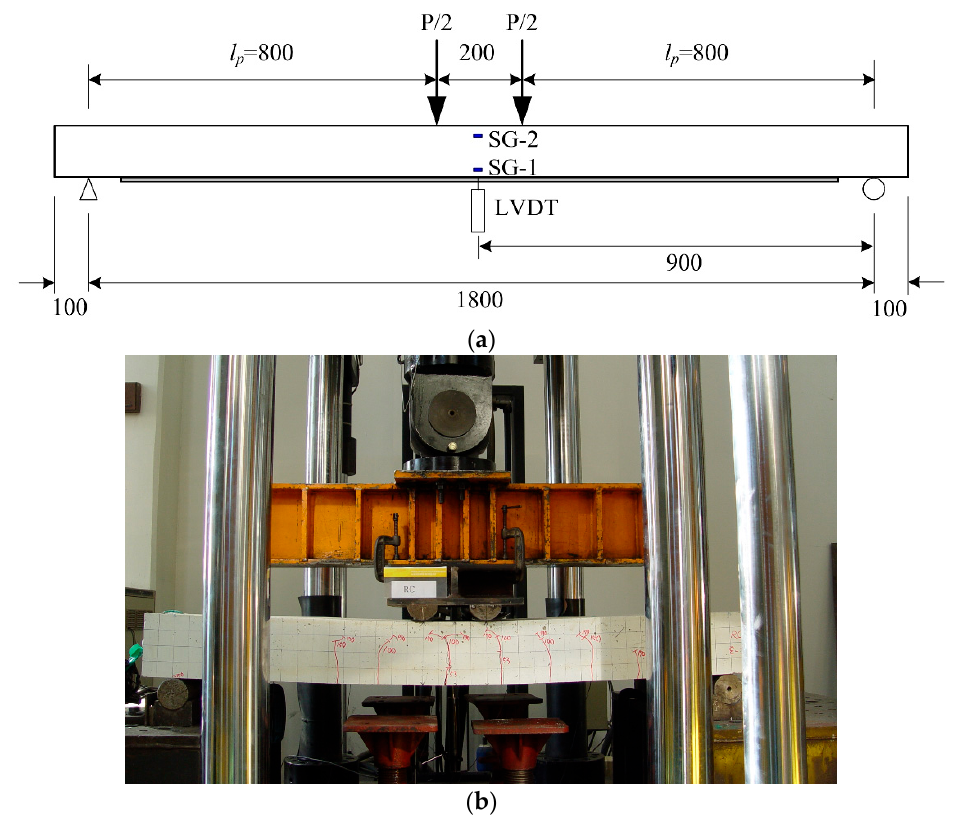
Figure 7. Full-scale flexural test setup and instrumentation. ( a ) Layout; ( b ) Photo (units, mm).